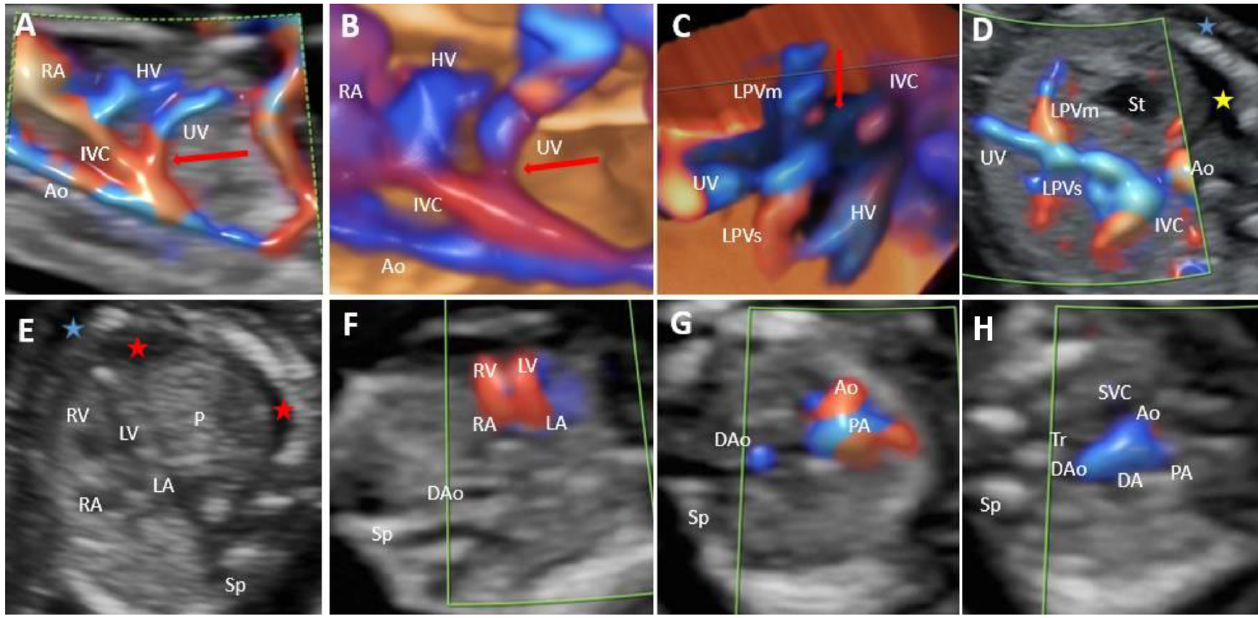
Figure 2. UPSVS type I with IVC drainage of the umbilical vein at 13 weeks of gestation (Case 1). ( A ) Color Doppler imaging in the longitudinal plane, showing the umbilical vein draining into the inferior vena cava. ( B ) Four-dimensional STIC reconstruction presenting the abnormal drainage of the umbilical vein (red arrow). ( C ) Four-dimensional STIC reconstruction, top view, showing the medial and superior branches of the left portal vein and the inferior vena cava drainage. ( D ) Axial view at the level of the fetal abdomen demonstrating the absence of the right portal vein and the umbilical vein connection to the inferior vena cava. Blue mark—skin edema, yellow mark—ascites. ( E ) Two-dimensional axial view at the thorax level showing the right-sided heart due to the presence of the pleural effusion (red mark). ( F ) Four-chamber view. During diastole, atrioventricular flows are visualized, separated by the interatrial and interventricular septum. ( G ) Color Doppler imaging, showing the pulmonary artery crossing the aorta in the axial plane. ( H ) Three vessels and trachea view showing the superior vena cava, pulmonary artery, ductus arteriosus, transverse aortic arch, and trachea. SVC, superior vena cava; Ao, aorta; PA, pulmonary artery; DA, ductus arteriosus; Dao, descending aorta; Tr, trachea. IVC, inferior vena cava; Sp, spine; RA, right atrium; LA, left atrium; RV, right ventricle; LV, left ventricle; P, lungs; UV, umbilical vein; HV, hepatic vein; Ao, aorta; LPVs, the superior branch of the left portal vein; LPVm, medial branch of the left portal vein; St,